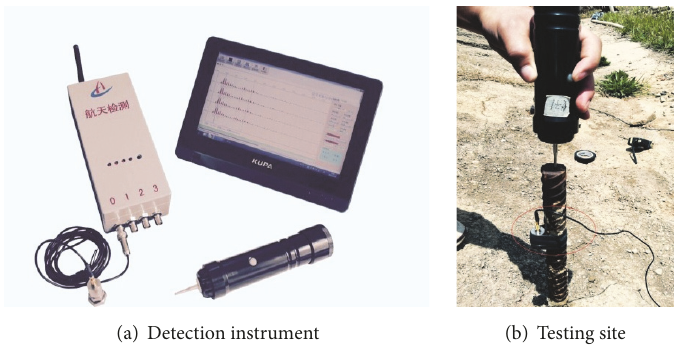
Figure 8: Bolt detection testing instrument and site.